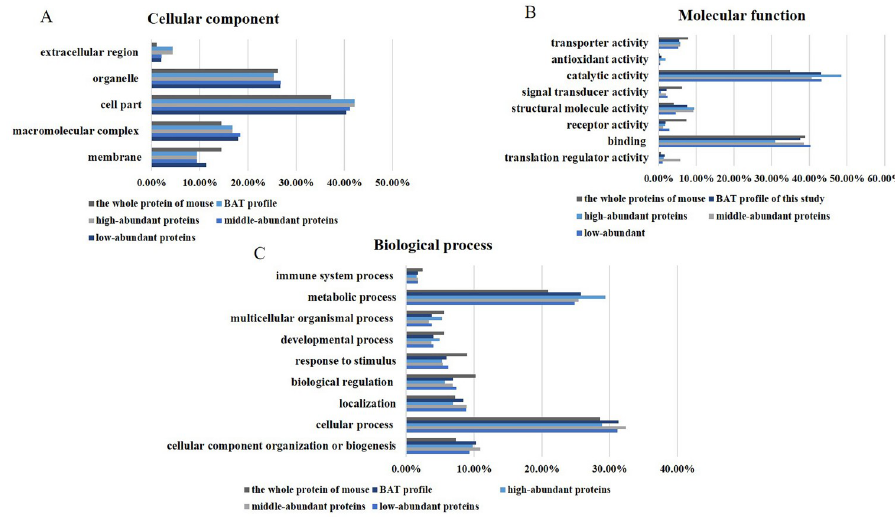
Fig 2. GO analysis of the BAT proteome. (A) Cellular component. (B) Molecular function. (C) Biological process.